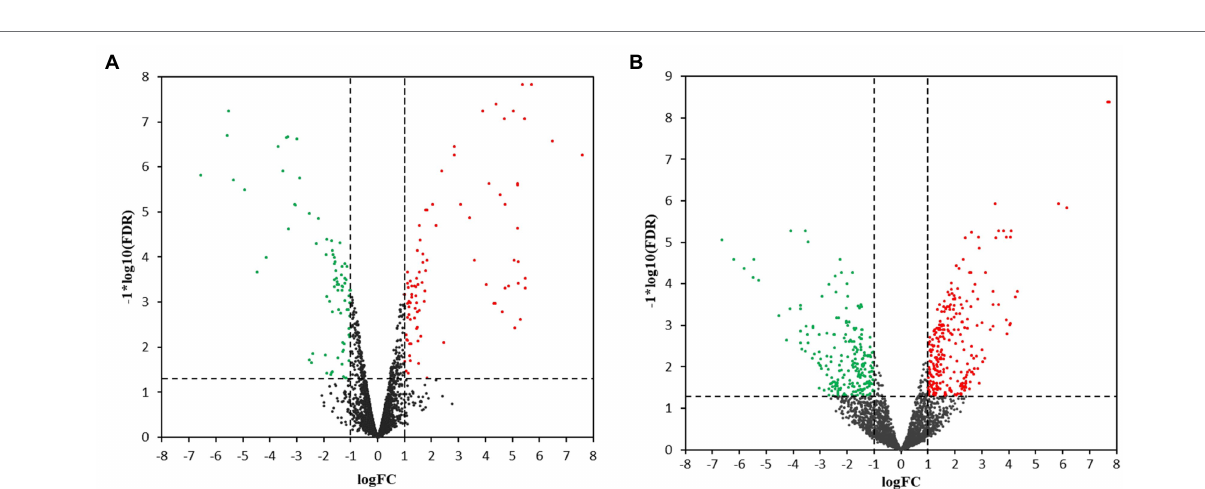
FIGURE 2 | Volcano plots for transcriptional profiles. Transcriptional changes resulting in the upregulation (red dots) or the downregulation (green dots) of genes were identified using scatter plots at (A) 3.5 h and (B) 24 h post-OLE treatment. Dashed lines represent values of p > 0.05 and genes demonstrating no change in expression level are shown by black dots. FDR, False Discovery Rate; FC, Fold Change.